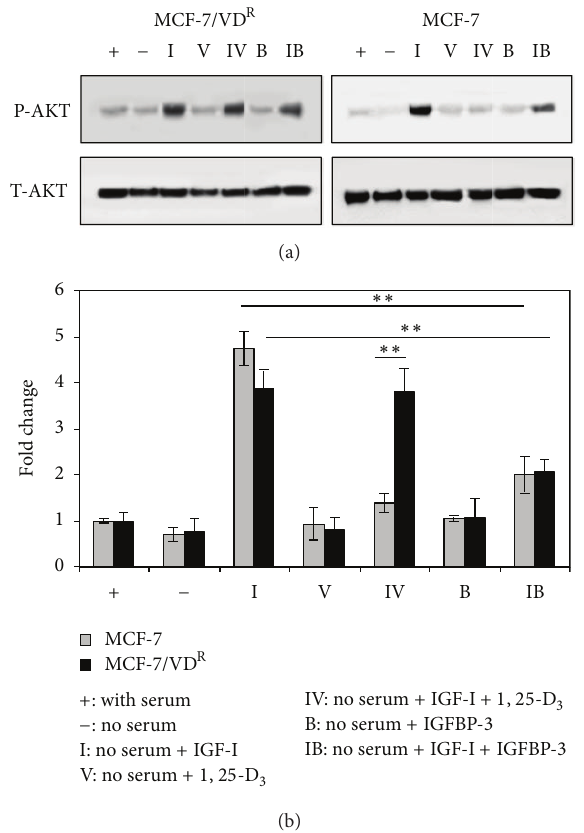
Figure 4: Differential modulation of IGF-induced Akt phosphory- lation in response to 1, 25-D 3 and IGFBP-3 treatment in MCF-7 and MCF-7/VD R cells. (a) MCF-7 and MCF-7/VD R cells were treated with 100nM 1, 25-D 3 or 30nM IGF-I, alone or in combination, in serum-free medium. Cells were also treated with 100nM IGFBP-3 alone or in combination with 30 nM IGF-I in serum-free medium. After 5 days of treatment, whole cell extracts were prepared and analysed by immunoblotting for total-Akt (T-Akt) and phospho-Akt (P-Akt). (b) Densitometric analysis of immunoblots was performed using GS-800 Calibrated Densitometer (Bio-Rad UK). Data shown are representative of three identical experiments. Means of 3 separated experiments are shown. ∗ 𝑃 < 0.05 and ∗∗ 𝑃 < 0.001 are statistically significant.